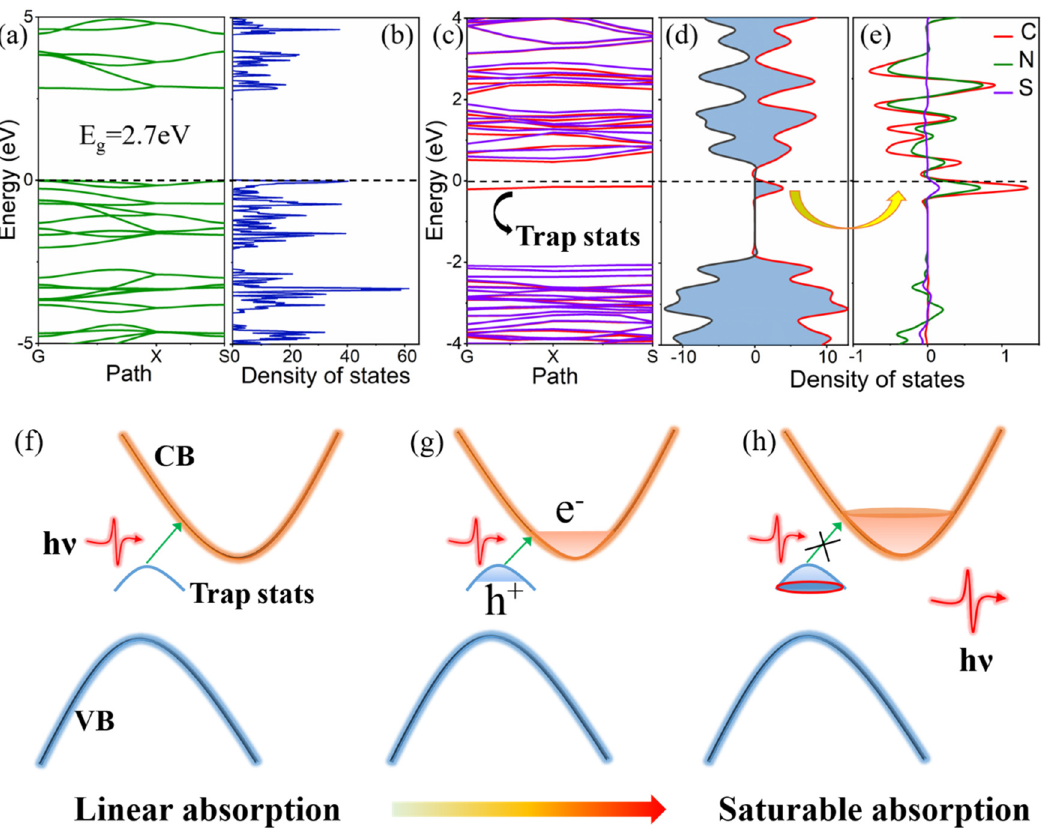
Figure8: (a)Thebandstructure,(b)totaldensityofstatesofpureg-C 3 N 4 .(c)Thebandstructure,(d)totaldensityofstates,(e)partialdensityof states of S-C 3 N 4 . (f – h) The schematic diagram of the saturable absorption mechanism of S-C 3 N 4